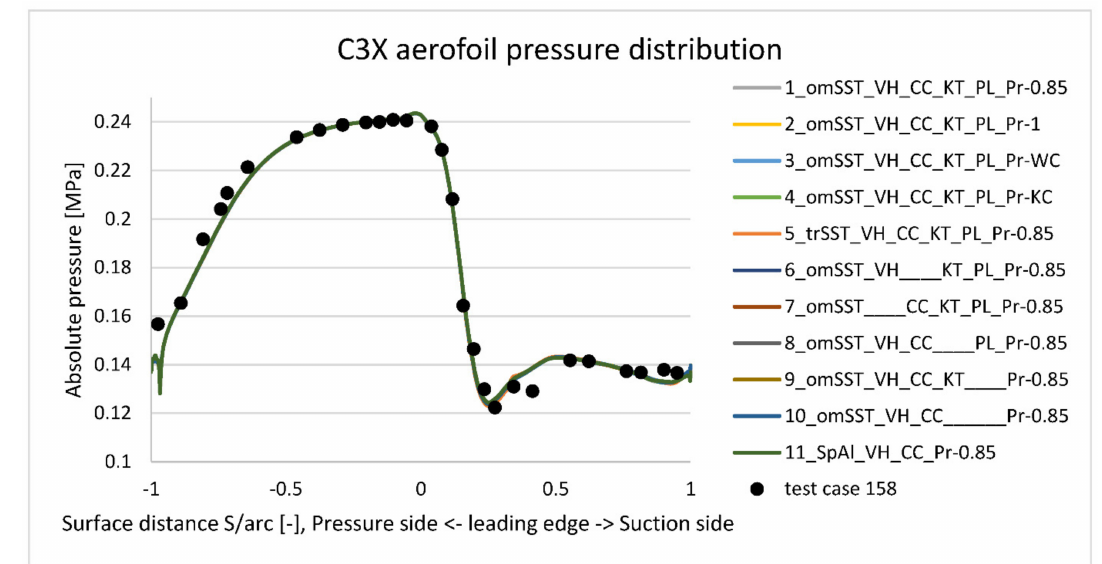
Figure 11. Predicted vane external absolute pressure at midspan versus experimental results (measurement uncertainty is ± 700 Pa).